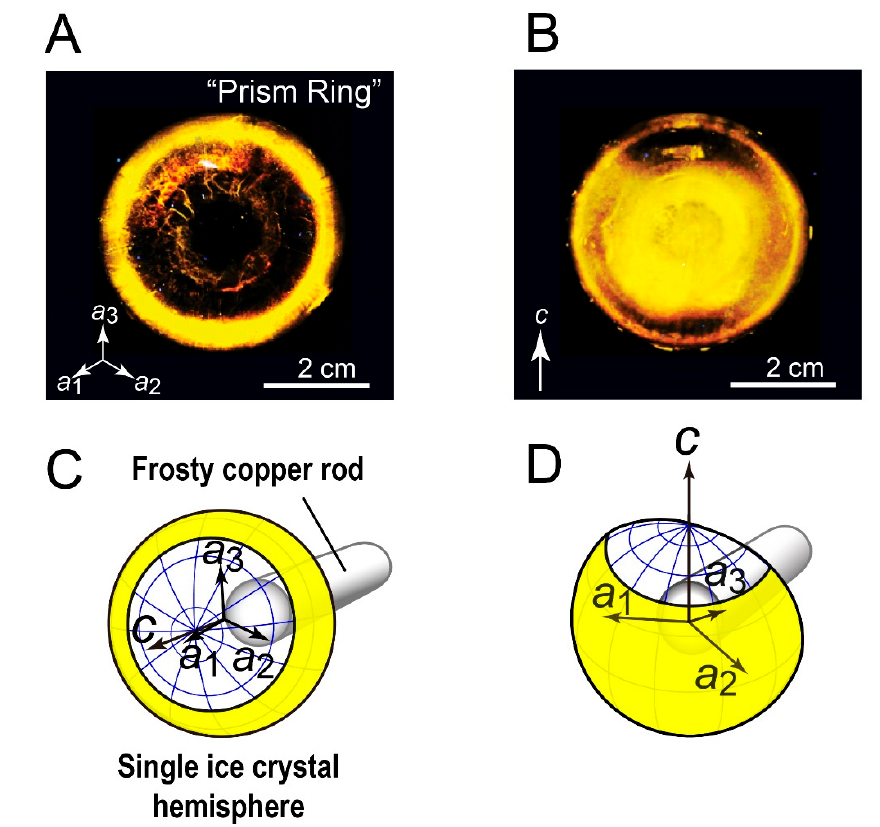
Figure 1. Observation of fluorescence-based ice plane affinity (FIPA) of Anp IBP. ( A ) A ring-like FIPA pattern of Anp IBP (denoted a “prism ring”). The ice hemisphere was mounted on a frosty copper rod to align its c -axis with the rod as illustrated in ( C ), and then soaked in 0.1 mg/mL protein solution to direct the c -axis downward. The prism ring was observed at the rim of the hemisphere, suggesting that Anp IBP binds to the water molecules that participate in both the primary prism and secondary prism planes. ( B ) The FIPA pattern of Anp IBP observed on a different ice hemisphere whose a 3 -axis is normal to the paper as illustrated in ( D ). The pattern shows that the prism ring observed in ( A ) is spread from the equator to a higher latitude.